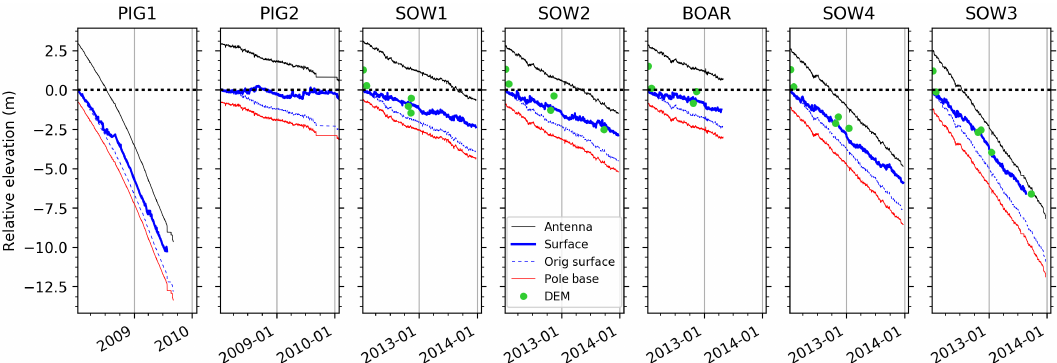
Figure 8. Time series of GPS antenna elevation (black), surface elevation (thick blue), tracer for initial surface (dotted blue), and pole-base elevation (red), all relative to initial absolute surface elevation. See schematic in Fig. 4. Green points show sampled WorldView DEM surface elevation. Note surface elevation decrease at all sites but